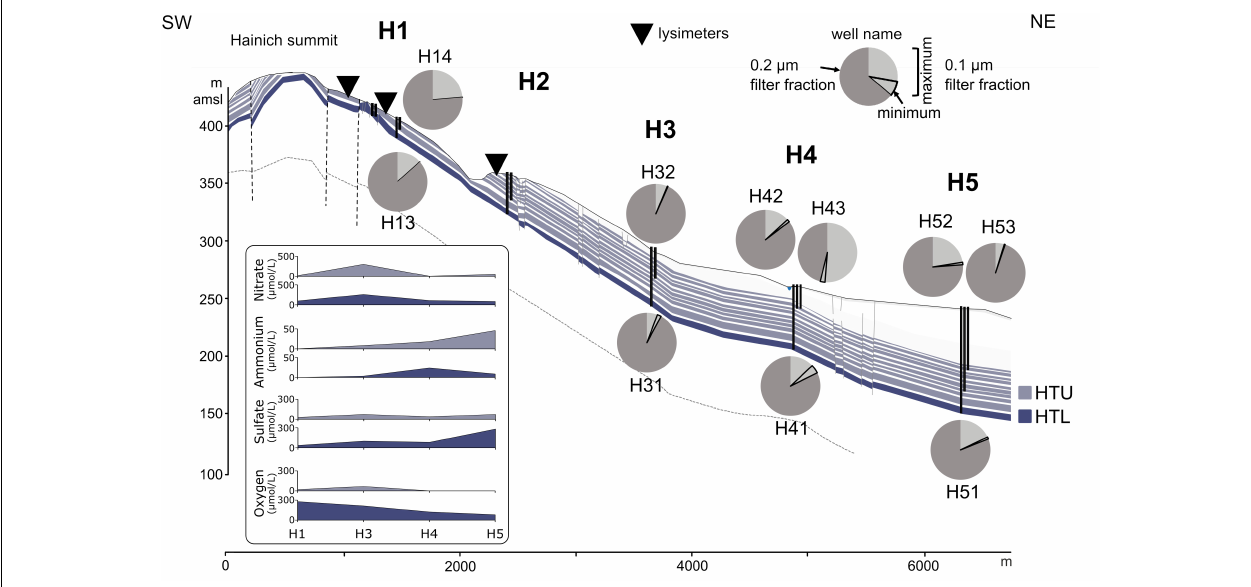
FIGURE 1 | Proportions of ultra-small cells in 0.1 and 0.2 µ m pore size filter fractions from groundwater samples along the eastern Hainich hillslope, aquifer configuration, and selected physicochemical parameters. Groundwater wells are shown as vertical black lines. The cross section [from Kohlhepp et al. (2017), modified] shows the karstified main aquifer [HTL; (wells H13, H31, H41, H51)] that is characterized by massive limestone beds and higher surface-connection by hilltop preferential recharge areas. The hanging thin-bedded alternating limestone-mudstone strata that host the multi-story upper aquifer assemblage (HTU; wells H14, H32, H42, H43, H52, H53) exhibit lower hydraulic conductivities due to a lesser intensity of karstification, yielding longer groundwater residence times. Faults are indicated by vertical dashed lines. Lysimeter installations used in this study are shown as inverted triangles. Quantification was based on 16S rRNA gene targeted qPCR (H13, H14: one sampling time point; other wells: two (H31) or six sampling time points). Dark gray section of the pie chart represents proportion of bacterial 16S rRNA genes associated with the 0.2 µ m filter fraction. Light gray section of the pie chart represents the maximum (encircled area: minimum) proportion of bacterial 16S rRNA genes associated with the 0.1 µ m filter